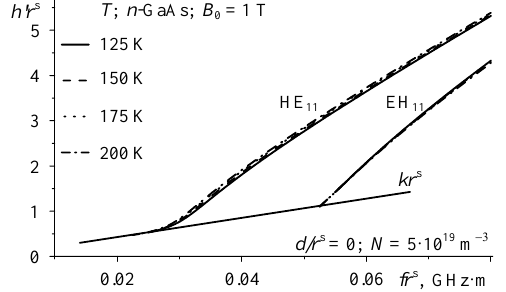
0 . 02 Fig. 6. Wave phase characteristics of models of gyroelectric n -GaAs semiconductor waveguides, when d / r s = 0; B 0 = 1 T; N = 5·10 19 m –3 . The significantly larger change of the phase coefficient of the main type HE 11 wave is obtained by using an external dielectric layer Rb 1− x (ND 4 )D 2 PO 4 . The phase characteristics of the semiconductor-dielectric waveguides with the external dielectric layer are presented in Fig. 7. It could be seen that wave phase characteristics are shifted to the lower frequencies when the external anisotropic dielectric layer is used. The bigger phase shift is obtained in the models of waveguides with the external anisotropic dielectric layer because the relative dielectric permittivity of one of the external dielectric layers depends on the temperature and